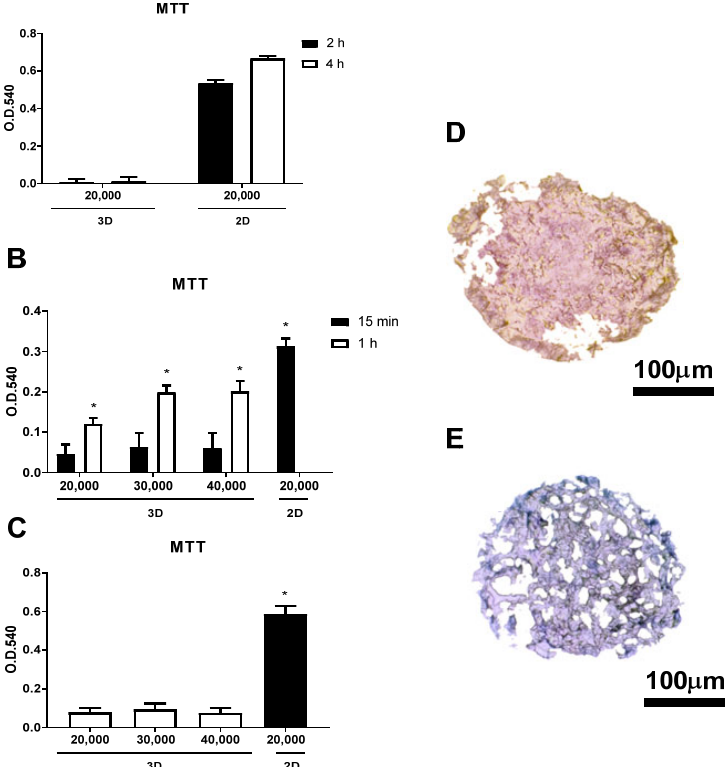
Figure 5. ( A ) Optical density of the MTT assay for two different times of incubation (2 h and 4 h; ( B )) Optical density for two different times of extraction (15 min and 1 h). Bars represent the mean ± SD (n = 5) optical density at 540 nm; ( C ) Comparison of the optical density obtained by a MTT assay performed with different cell densities for the 3D model, and the seeding of 20,000 cells for the 2D model. Black bars indicate the results obtained with monolaminar cell culture of MC3T3 ‐ E1 cells form the same origin as those used in the aggregates. ( D ) 7 μ m section of spheroid with 20,000 cells after the incubation with Formazan for 2 h; ( E ) 7 μ m section of spheroid with 20,000 cells after the extraction with DMSO for 1 h. All experiments were performed with spheroids at the 4th day after formation.